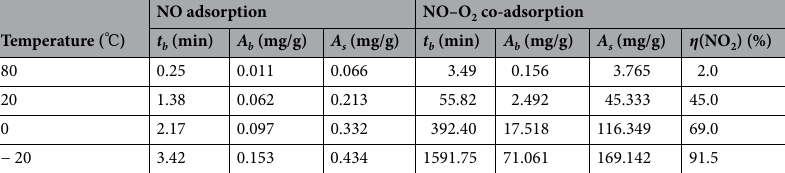
Table 4. Adsorption characteristics of NO and NO–O 2 over CAC at various temperatures (NO = 200 ppmv, O 2 = 6 vol.%, space velocity = 5000 h −1